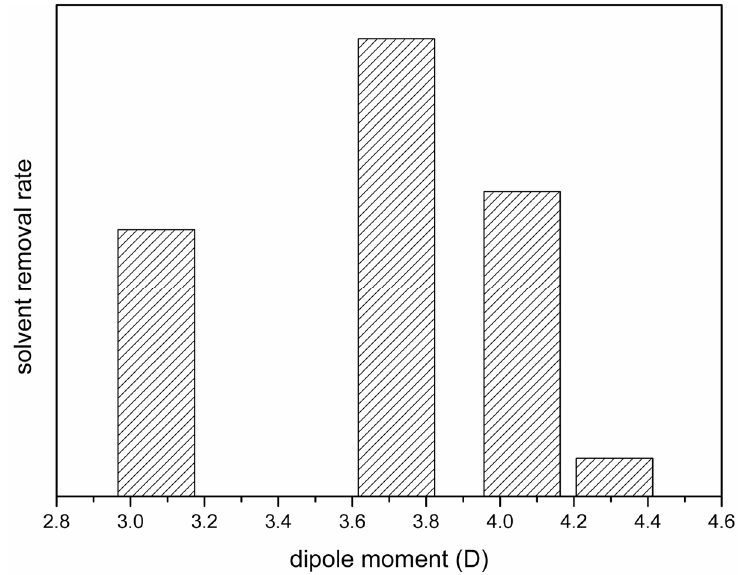
Figure 10. Schematic presentation of the dependence of the solvent removal rate in coagulation bath on its dipole moment.